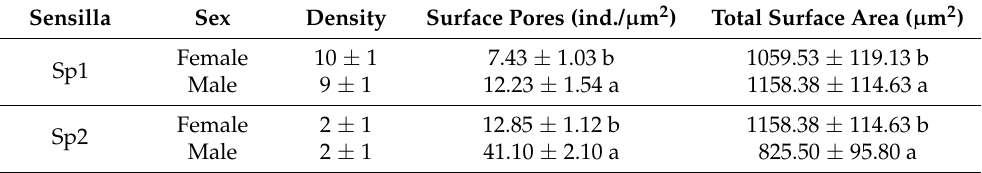
Table 4. Features of the sensilla placodea of the antennae of female and male C. qinlingensis (N =